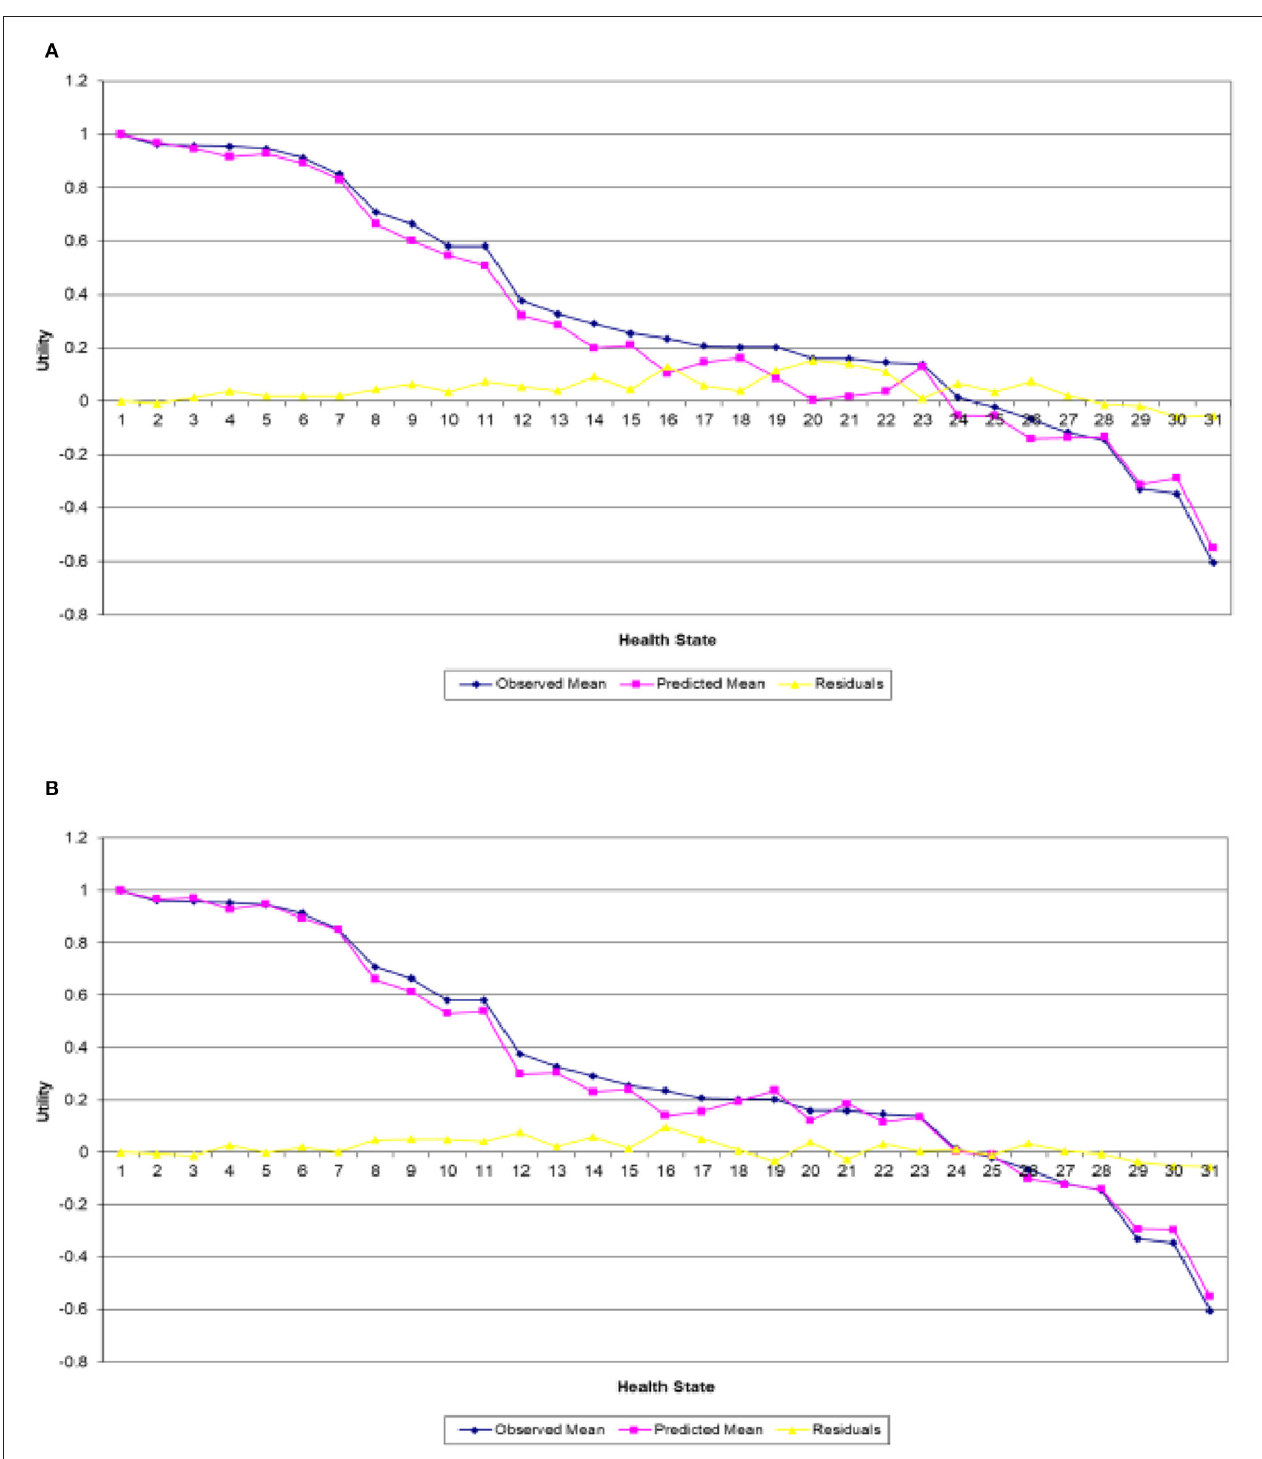
FIGURE 1 | Actual and predicted mean health states valuations generated from analyzing. (A) Irish data only and (B) Irish data with Polish results as informative priors.